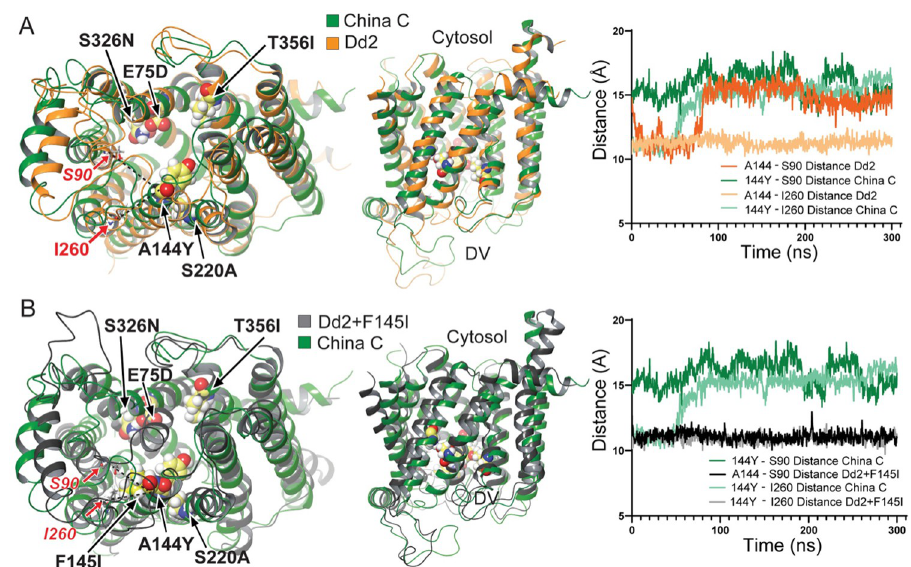
Fig 3. Molecular dynamics simulations illustrate unique central cavity conformations between the PPQ-resistant China C and Dd2+F145I. PfCRT isoforms. ( A ) Simulations of molecular dynamics on the 7G8 structure harboring mutations in the China C or Dd2 isoforms and modelled over 300-nanosecond (ns) trajectories, indicating equilibrium positions of protein side chains and predicted distances between position 144 and residues on proximal helices. ( B ) Molecular dynamics simulations for the 7G8 structure harboring the China C or Dd2+F145I mutations, also showing equilibrium positions of protein side chains and predicted distances between position 144 and residues on proximal